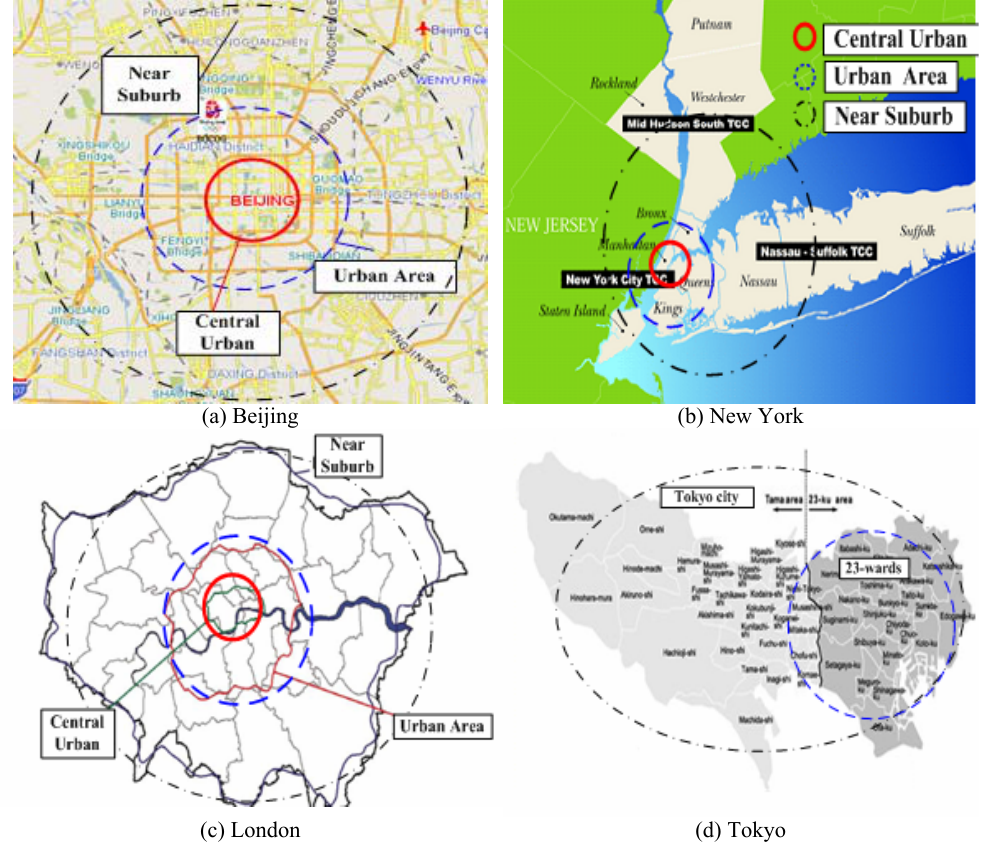
Fig. 1. Areas division in study